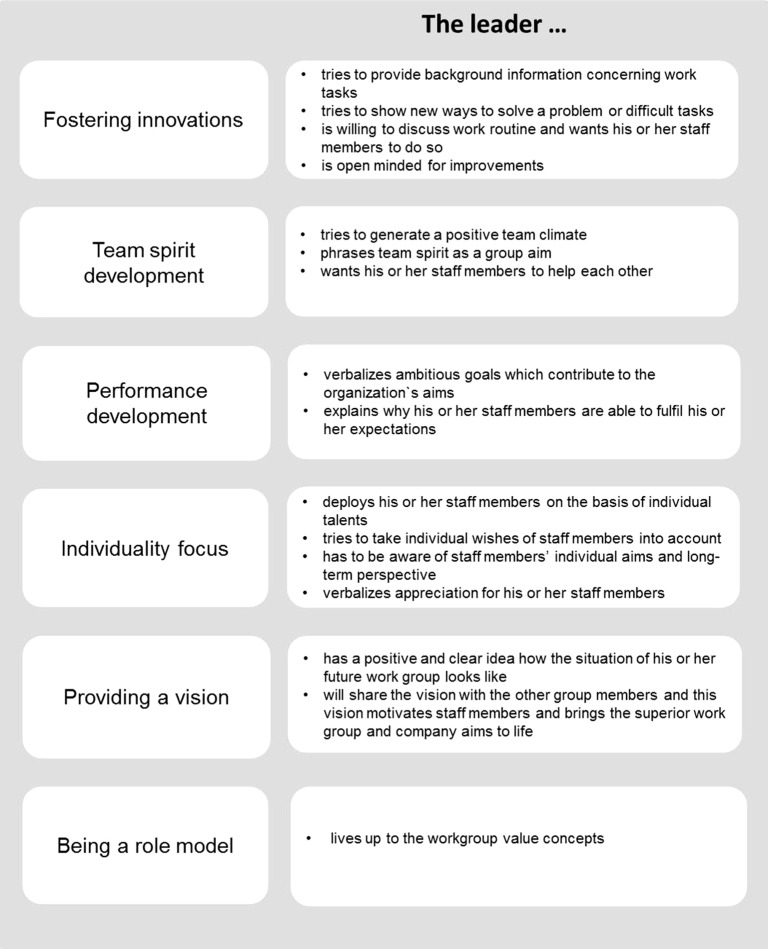
Description of transformational leaderships sub-dimensions (translated by the authors from the description by 28, pp. 8–9).